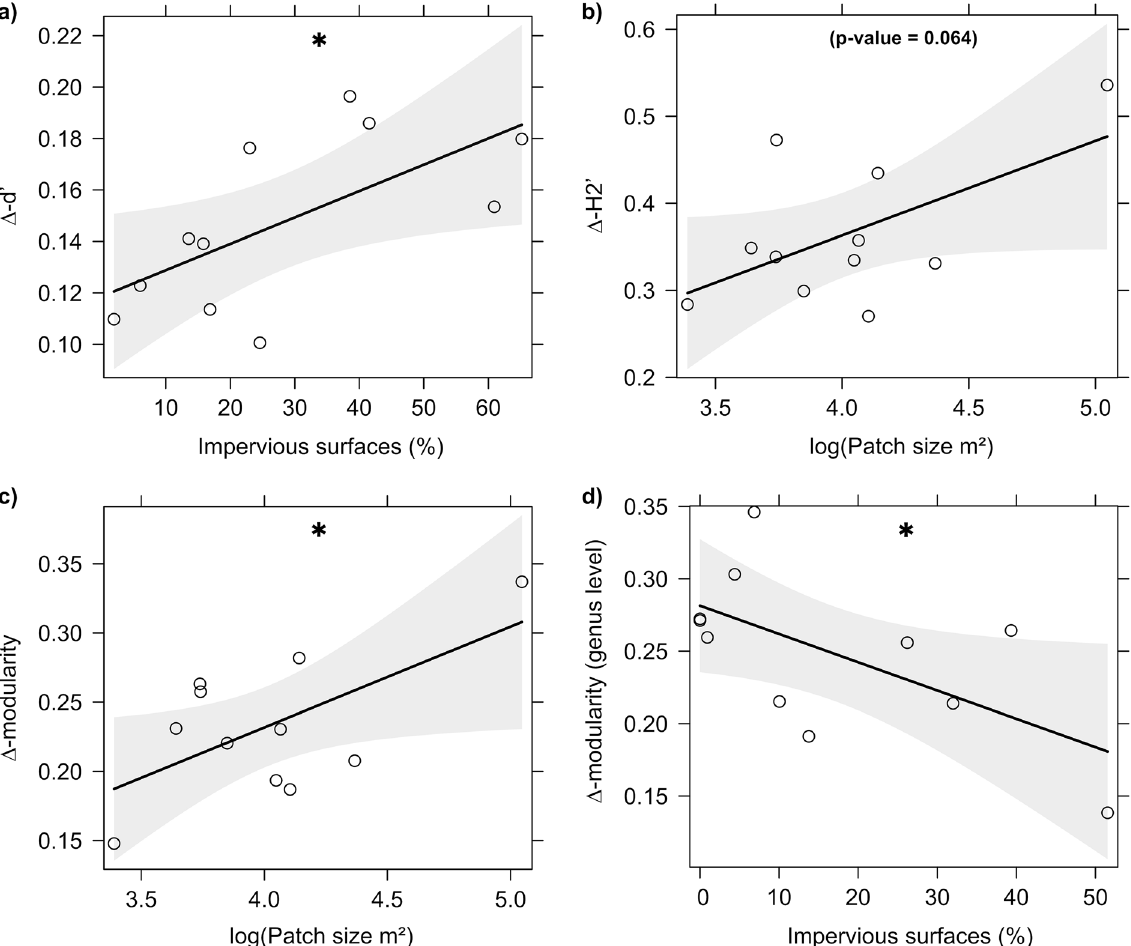
Figure 3. Relationships between ( a ) flower visitor specialisation (∆-d´) and impervious surfaces (1000 m); ( b ) network specialisation (∆-H2´) and log-transformed patch size; ( c ) network ∆-modularity and log-transformed patch size; ( d ) network ∆-modularity (genus level) and impervious surfaces (100 m). Plotted lines show the predicted relationship and shaded areas indicate the 95% confidence intervals. *P <